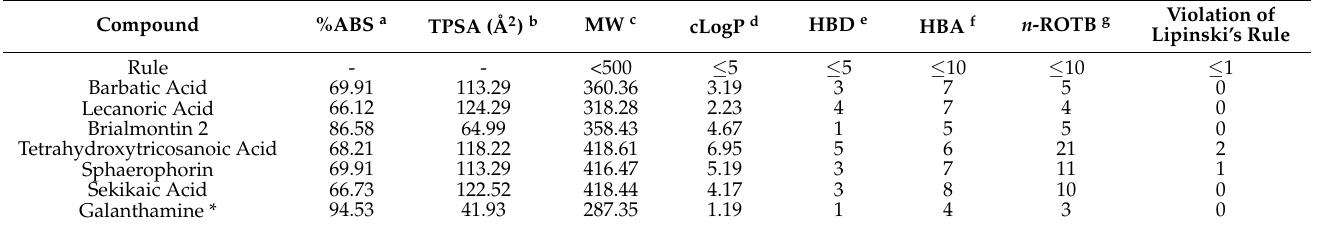
Table 7. Pharmacokinetic properties of compounds in the extracts of Lecania brialmontii , Pseude- phebe pubescens and Sphaerophorus globosus in comparison with the standard inhibitor galanthamine on acetylcholinesterase (TcAChE) and butyrylcholinesterase (hBChE) obtained from Osiris Data Warrior